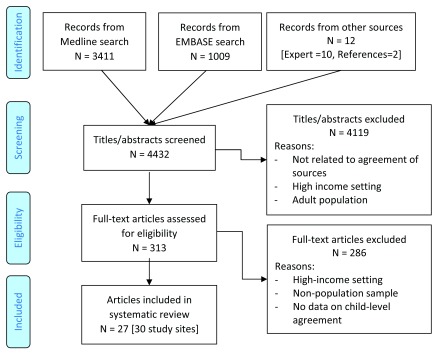
Article screening.